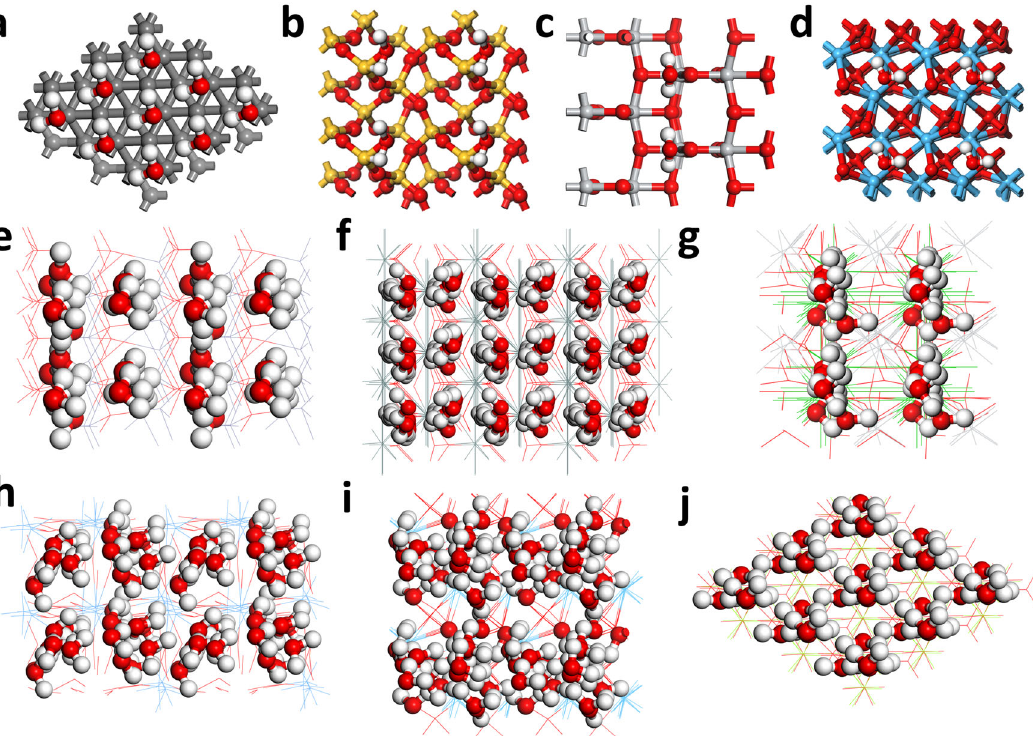
Fig. 1 The top view of different solids after CE with water. Single-layered water on a Diamond, Gray balls = C, b SiO 2 , Yellow balls = Si, c TiO 2 , Silver balls = Ti, and d HfO 2 , Blue balls = Hf. Red balls = O and White balls = H. For the multi-layered water models, the solid materials have been displayed by lines to deliver a clear demonstrations. Multi-layered water on e ZnO, Dark silver line = Zn, f SnO 2 , Grey line = Sn, g MgO, Light green line = Mg, h HfO 2 , Blue line = Hf, i Ta 2 O 5 Light blue line = Ta, and j BaTiO 3 , Green line = Ba. Red balls = O and White balls =